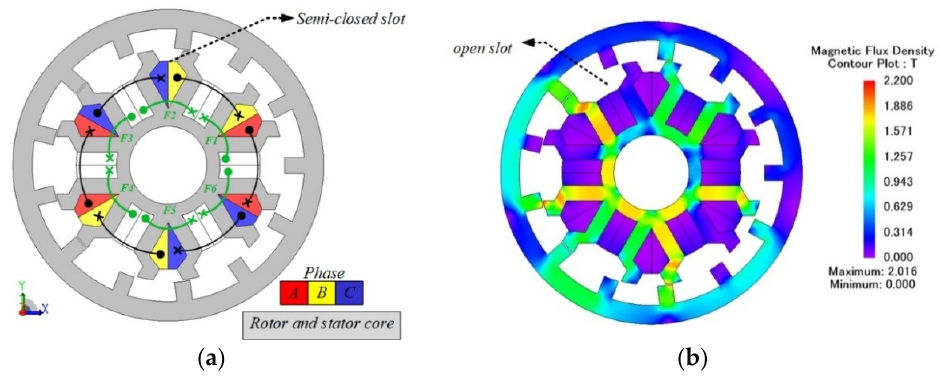
Figure 1. Proposed OR-FEFSM ( a ) cross-sectional view and ( b ) magnetic flux density map.